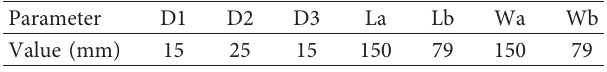
Figure 3: Geometry and dimension of a four-layer odd function symmetrical dual-polarization equilateral right triangle slot printed broadband directional antenna. Table 3: Dimensions of a four-layer odd function symmetrical dual-polarization equilateral right triangle slot printed broadband directional antenna.